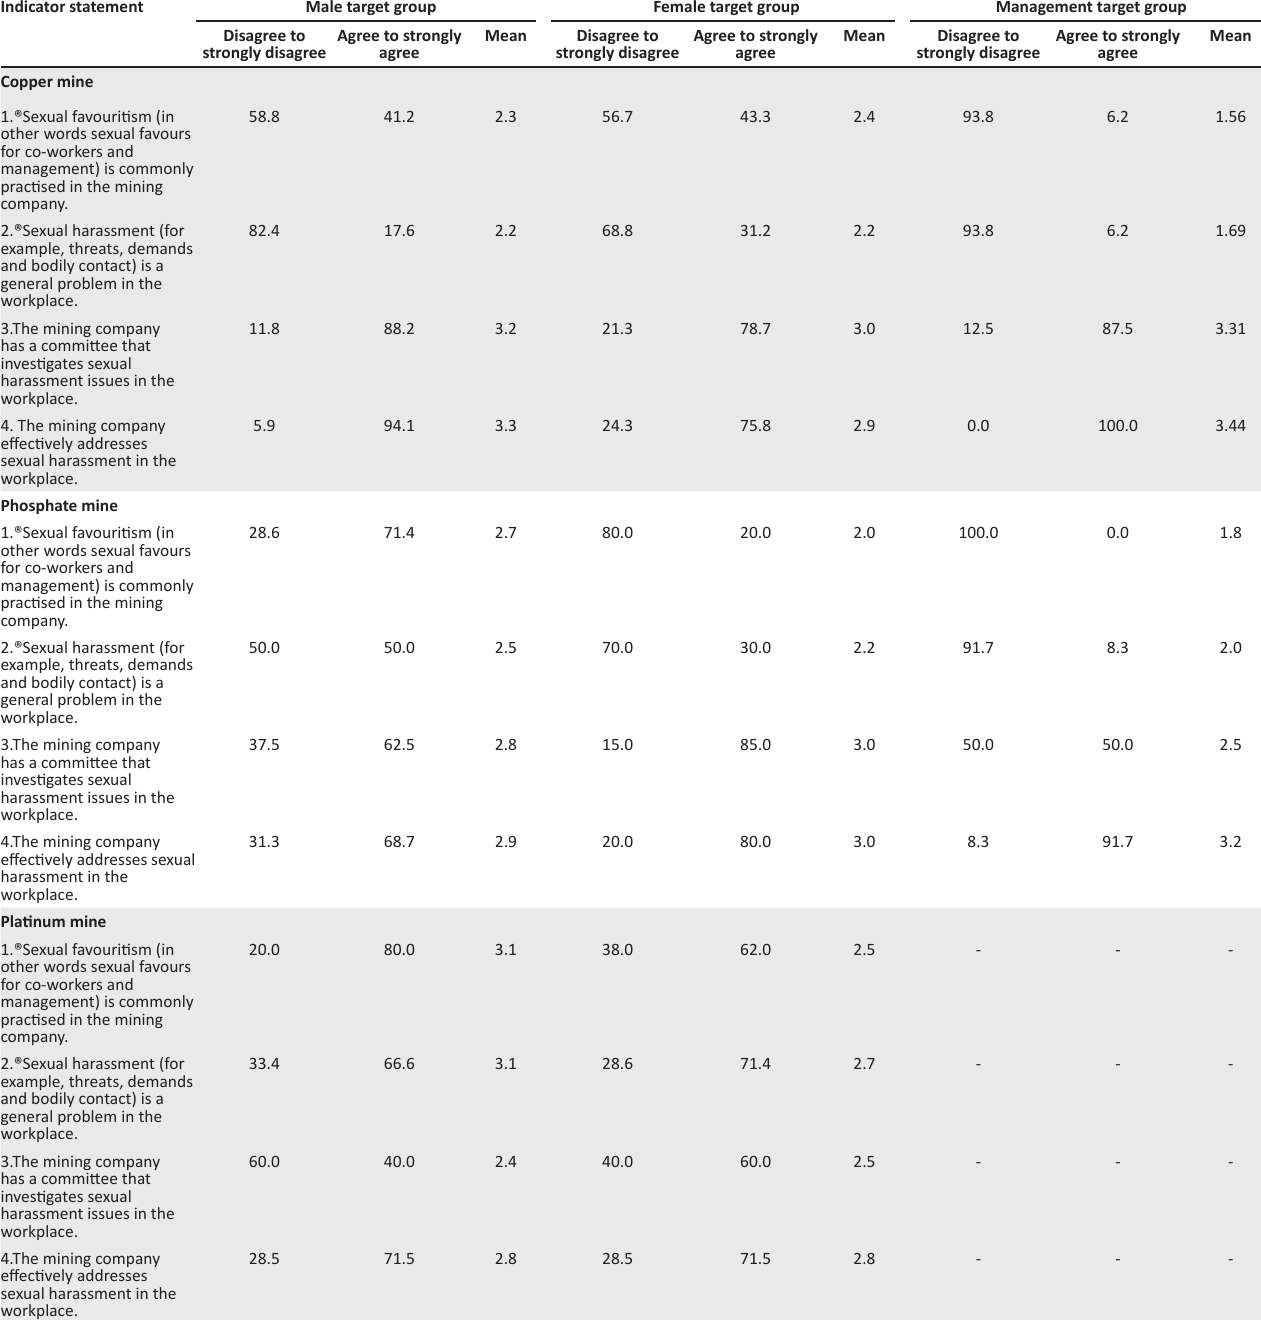
TABLE 3: Participants’ perceptions regarding sexual harassment and sexual favouritism in the workplace. Indicator